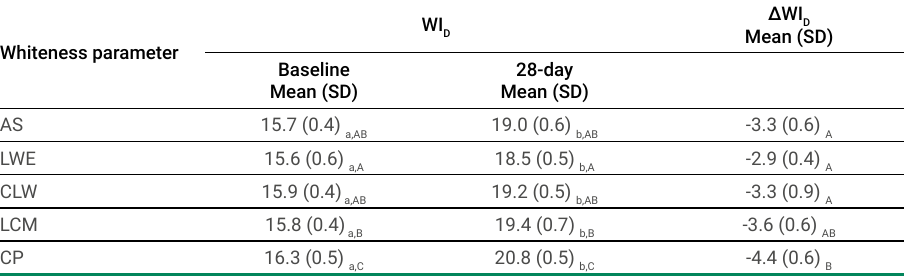
Lower case letters represent the comparison of groups in lines; capital letters represent the comparison of groups in columns; different letters reveal statistically significant differences in